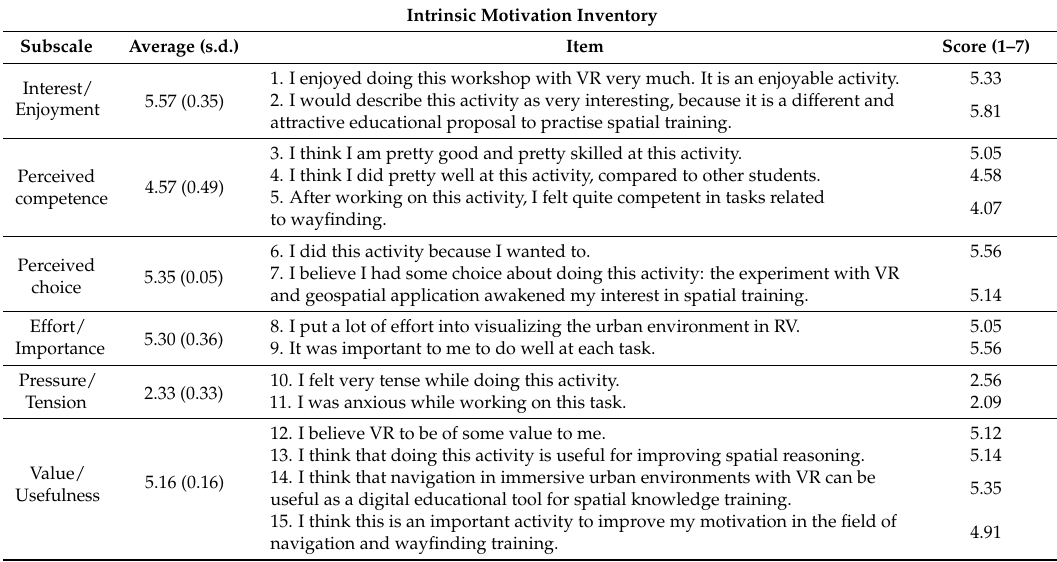
Table 1. Intrinsic Motivation Inventory. (s.d. Standard deviation)